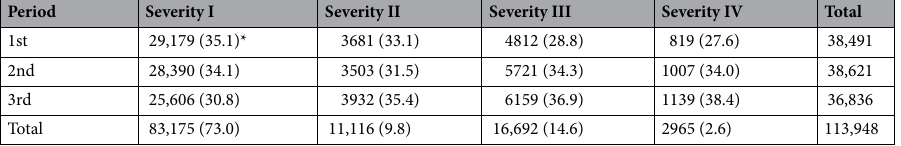
Table 2. Severity distribution of total study population according to the assessment period. *Percentage of patients by assessment period (%).